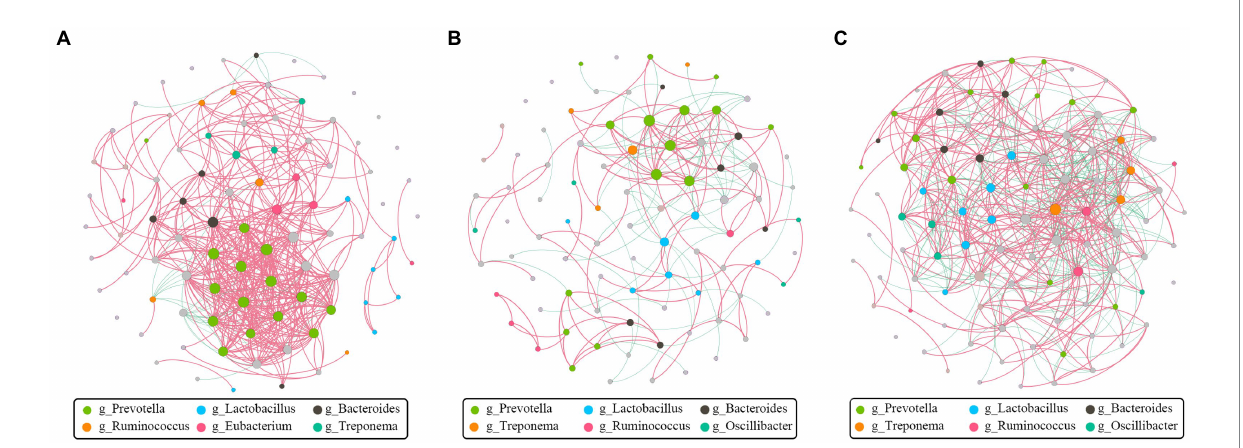
FIGURE 7 Co-correlation analysis of bacterial network by different stages. Each node represents a species, the size of each node is proportional to the relative abundance, and the color of the nodes indicates their taxonomic assignment. The red and green lines represent the positive and negative correlations, respectively. Only lines corresponding to correlations with a magnitude greater than 0.5 are shown. (A) Pre-weaning stage. (B) Weaned stage. (C) Growth stage.